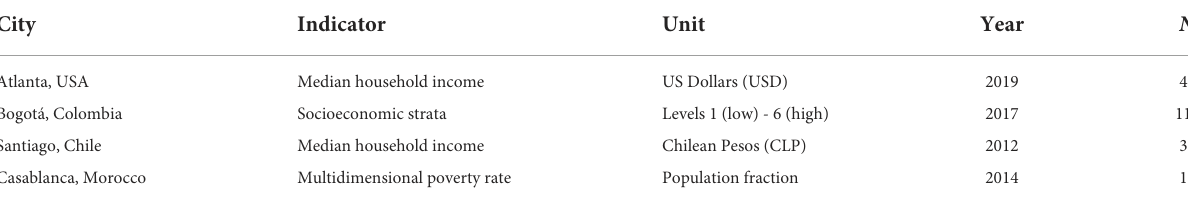
TABLE 1 Socioeconomic indicators used in the study and their corresponding data sources.